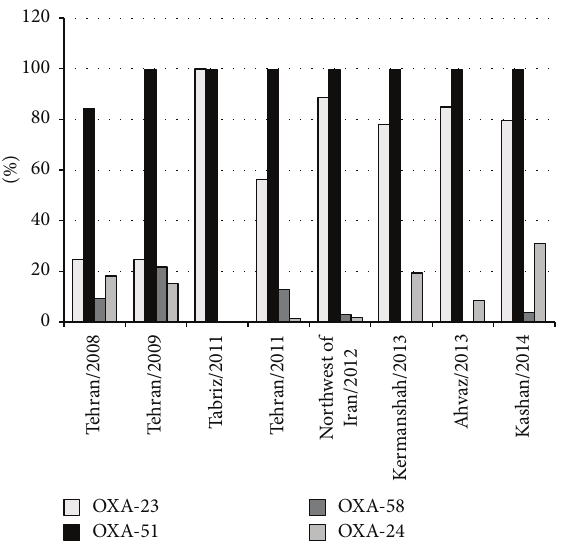
Figure 2: Frequency rates of 𝑏𝑙𝑎 OXA genes in A. baumannii isolates in Iran (2008–2014).